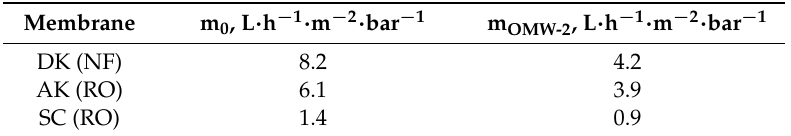
Table 4. Measured pure water permeability (m 0 , L · h − 1 · m − 2 · bar − 1 ) and permeability with olive mill wastewater OMW-2 (m OMW-2 ) of the virgin membranes used.